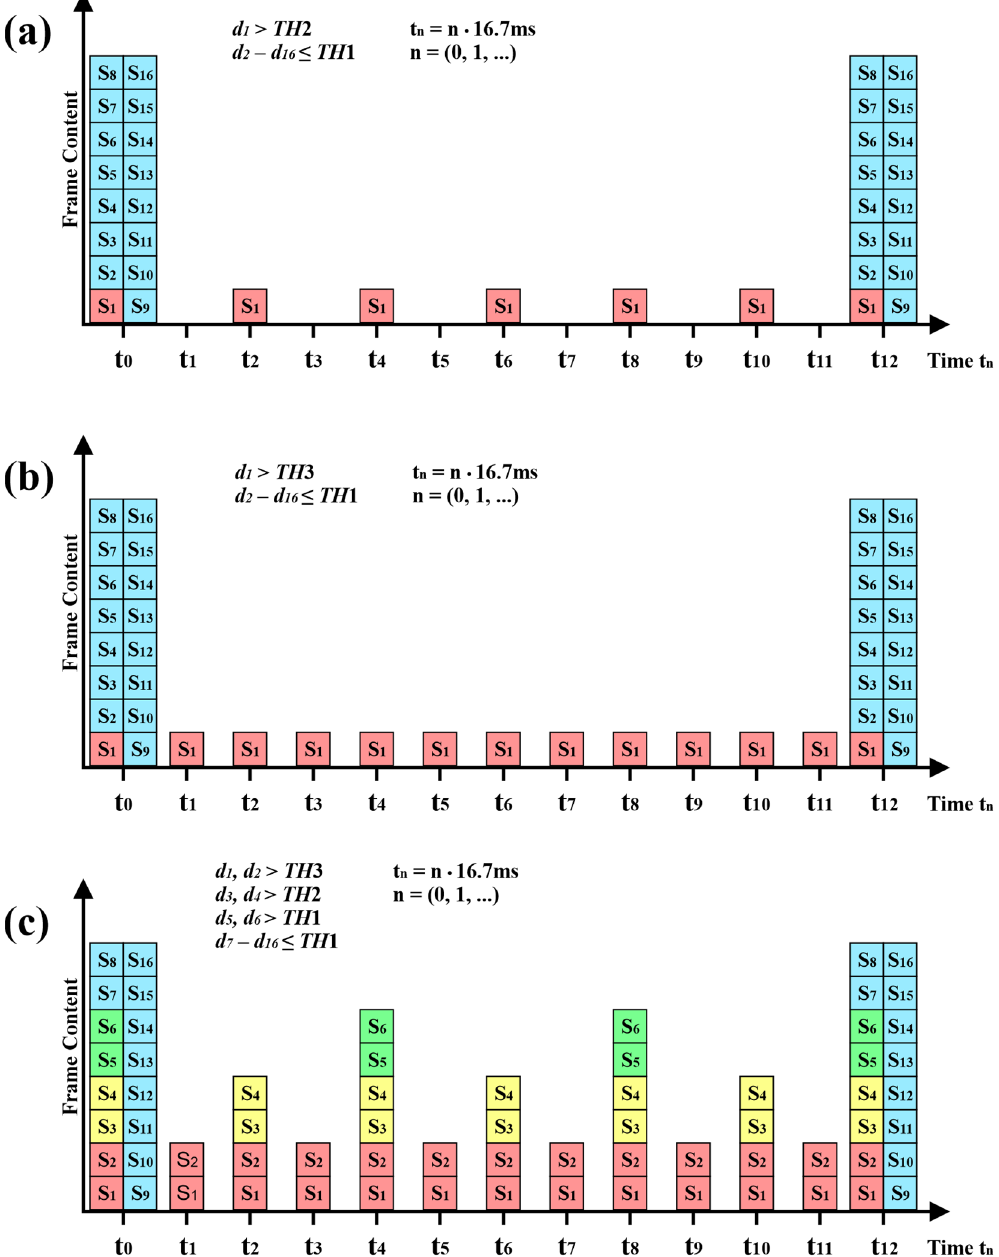
Figure 8. Structure of data transmission from individual MEMS sensors.